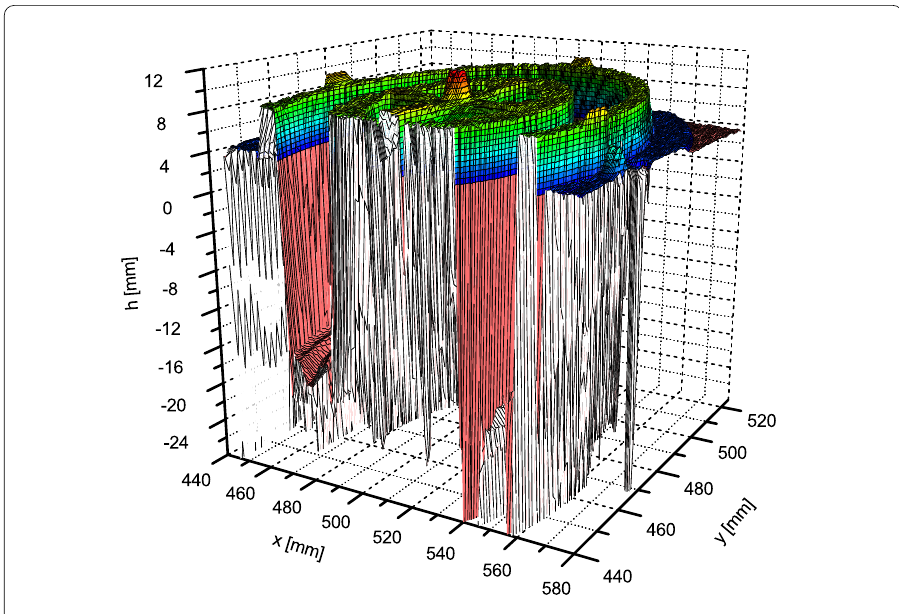
Figure 14 Section of a full TLH mapping of the